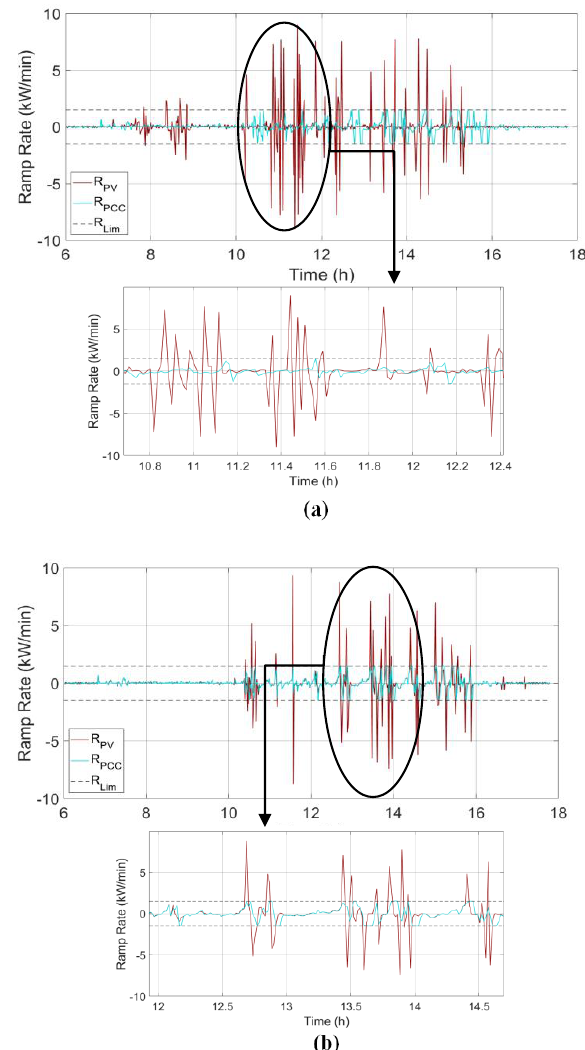
Figure 7. Rate of change of photovoltaic power and injected power: ( a ) most critical day and ( b ) average day.